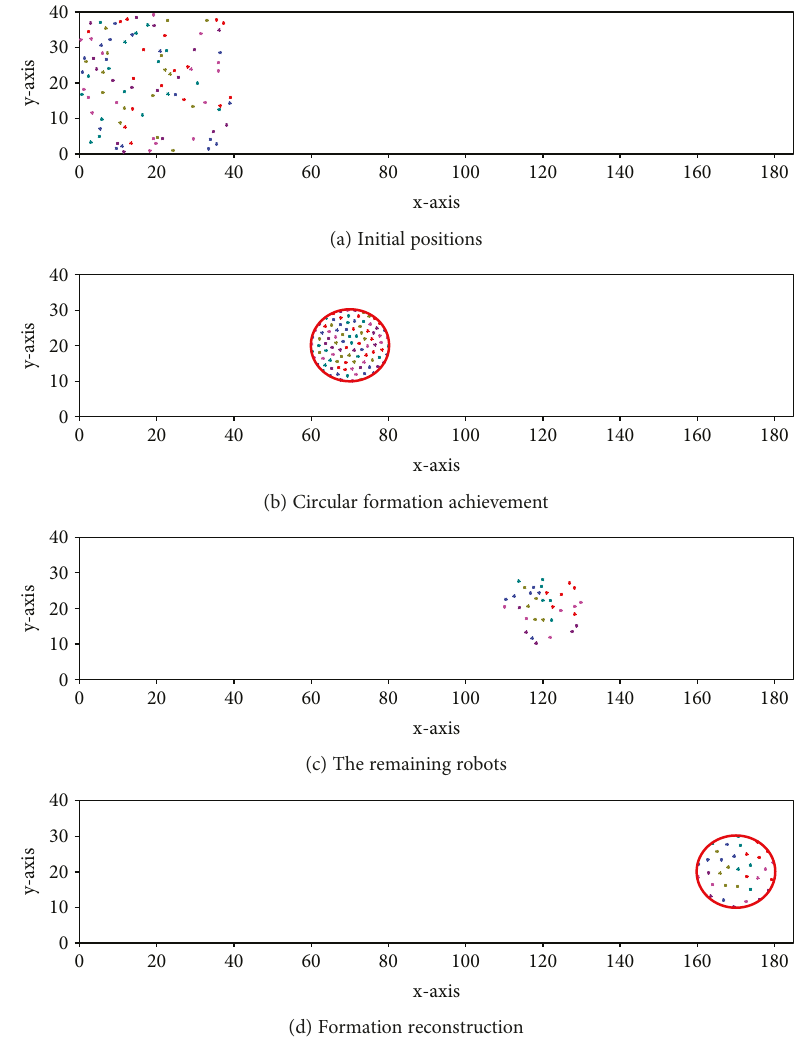
Figure 2: Formation reconstruction with the remaining